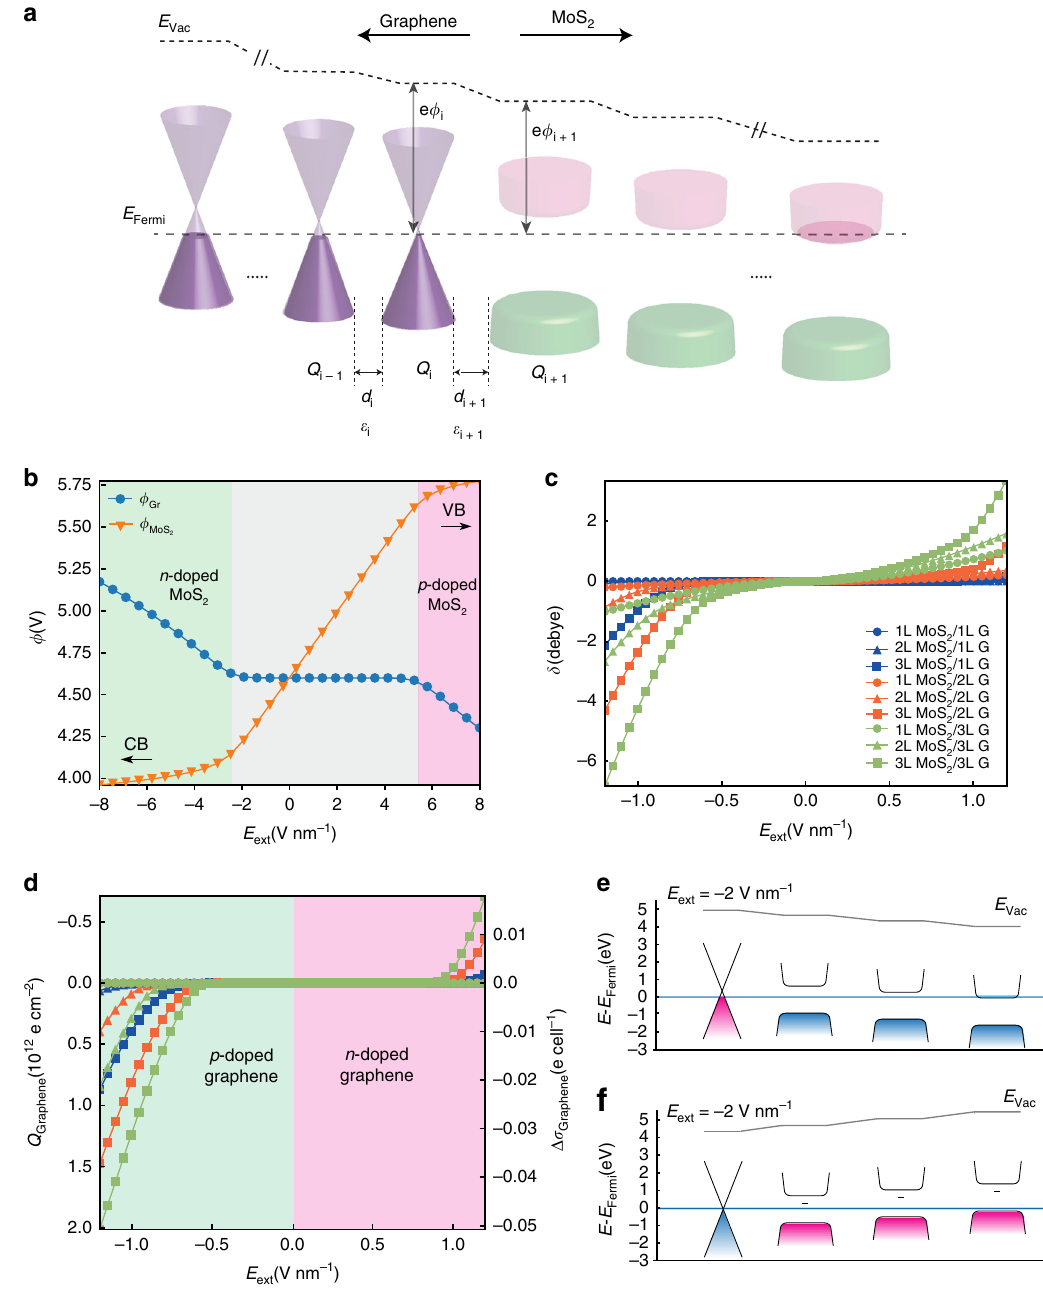
Fig. 6 Classical electrostatic approach for charge redistribution of MoS 2 /Graphene vdW heterostructures. a Schematic band diagram of the multilayer MoS 2 /Graphene heterostructures. Vacuum level ( E vac ), work function ( ϕ i ), surface charge density ( Q i ), interlayer distance ( d i ), and relative permittivity ( ε i ) are shown for each stacking i . b Work functions of graphene and MoS 2 as functions of external electric fi eld E ext (V nm − 1 ). The regimes of the n-doped and p-doped MoS 2 are highlighted in green and faint red, respectively. The Fermi level reaches the conduction band (CB) or valence band (VB) of MoS 2 when large negative or positive E ext is applied, relatively (as shown by the arrows). c Electric dipole moment δ (Debye) as a function of E ext (V nm − 1 ) for different number of graphene and MoS 2 layers on the heterostructures. d Surface charge density Q Graphene (left axis) and the amount of charge transfer between graphene and MoS 2 layers Δσ Graphene (right axis) as a function of E ext (V nm − 1 ) for different MoS 2 /Graphene systems. The curves follow the labeling in ( c ). e – f Band alignments for an illustrative case, e.g., 3L MoS 2 /1 L Graphene under − 2.0 V nm − 1 and + 2.0 V nm − 1 electric fi elds, respectively. Positive charges are shown in faint red and negative charges are shown in blue, respectively. Only band structures near the Fermi level are shown for